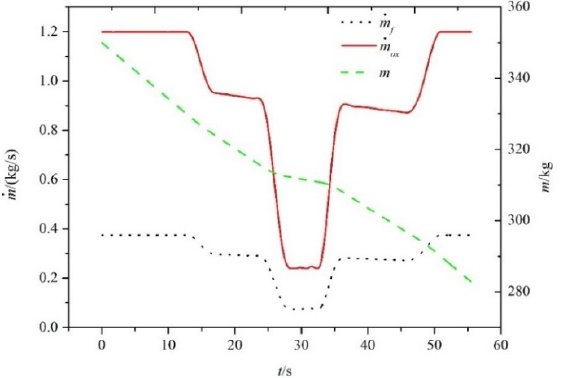
Figure 8. Propellant mass flow rates and vehicle mass in the first scenario vs. time.